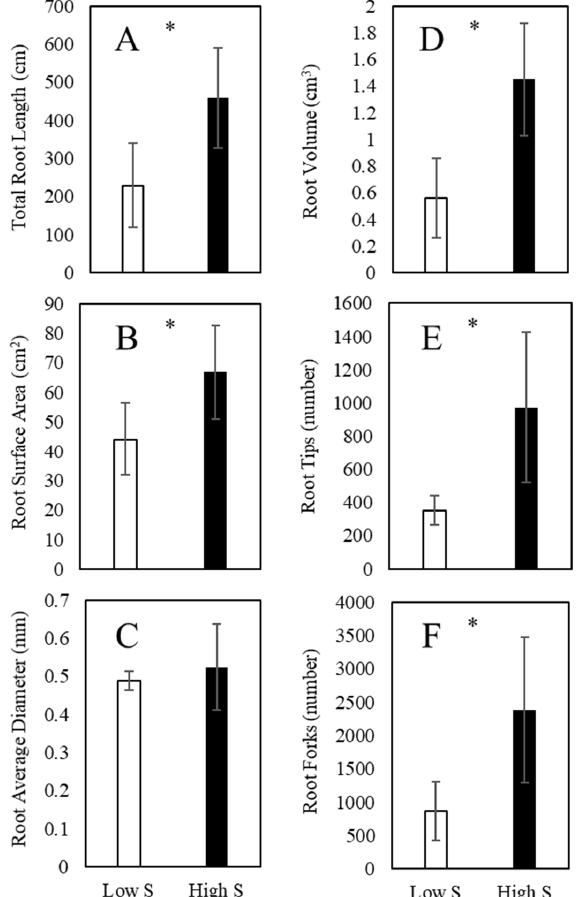
Figure 4. Changes in the total root length ( A ), root surface area ( B ), average root diameter ( C ), root volume ( D ), root tips ( E ), and root forks ( F ) of lettuce grown in low and high sulfur concentration under LED spray system. Vertical bars represent the standard deviation of the mean (n = 5). Asterisks indicate significant differences. * p value < 0.05.